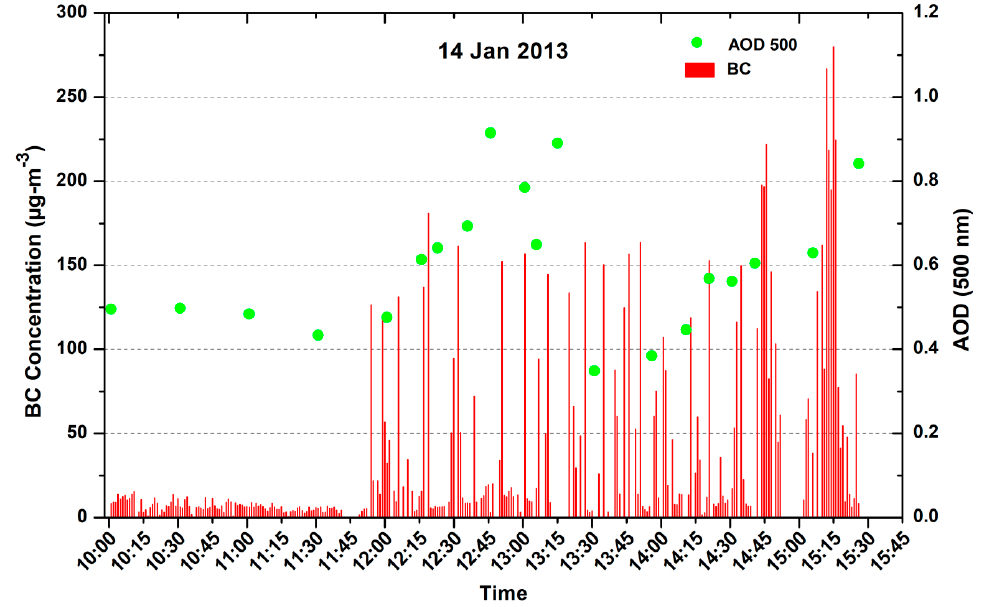
Figure 7. Measurement of AOD (500 nm) and BC at fixed site (10:00–11:45 hrs) and in transit near the thermal power plants (11:45–15:30 hrs).